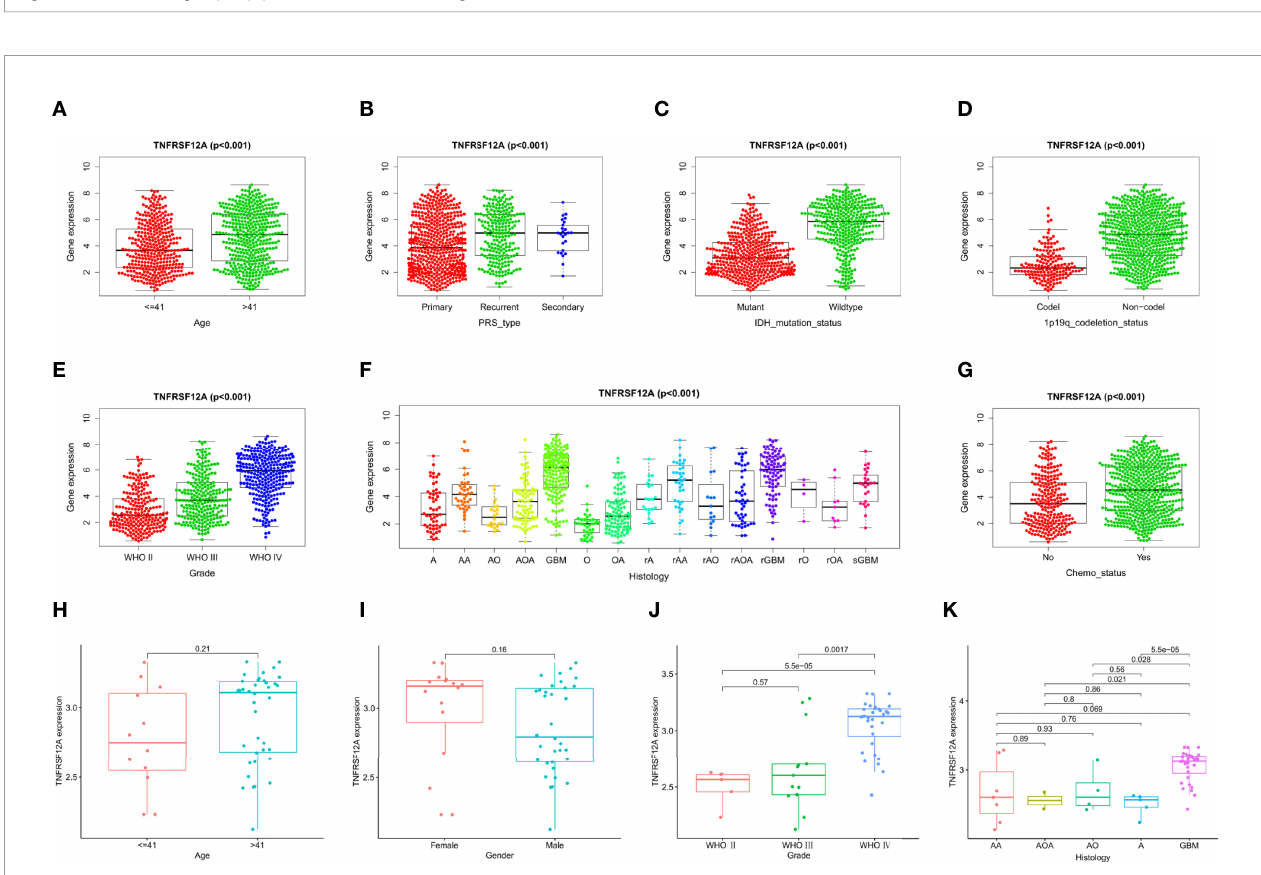
FIGURE 6 | (A) Risk score grouping of samples in CGGA. (B) Survival time corresponding to the patient risk score in CGGA. (C) Survival analysis of patients in high-risk and low-risk groups. (D) ROC curve for the nomogram.